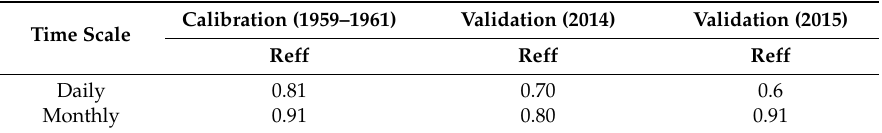
Table 2. Description statistic and goodness for calibration (1959–1961) and validation